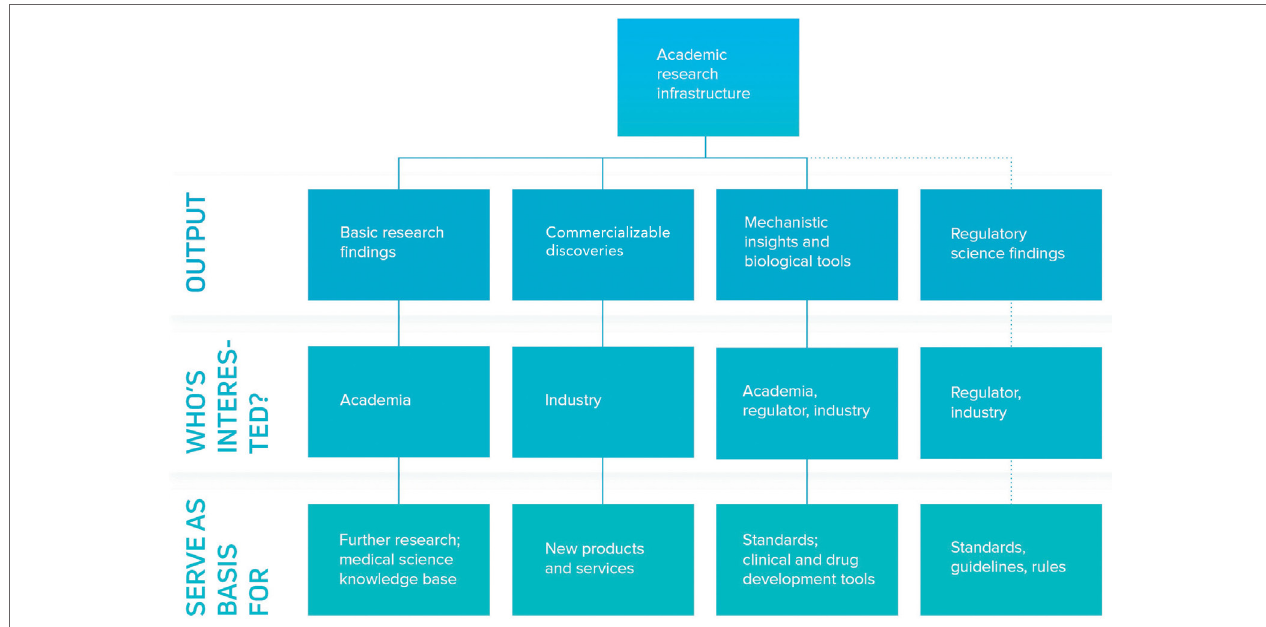
FiGUre 1 | Academia in the knowledge and innovation cascade. Academia plays an important role in the generation of novelty in the advanced therapy medicinal product (ATMP) space. The first three strands of the innovation cascade are well established, with academic publication mediating delivery of basic research findings and novel biology and tools, with intellectual property (most commonly in the form of patents or industrial secrets) serving as a vehicle for commercializable discoveries. The fourth strand depicting a regulatory science framework is poorly developed in Europe but a pressing need in ATMP development and would require structural dialogue between regulator, academia and their funders, and industry. Research infrastructures have a role to play in defragmenting the academic field, sourcing independent labs, and acting as a trusted third party in the interplay between regulator and